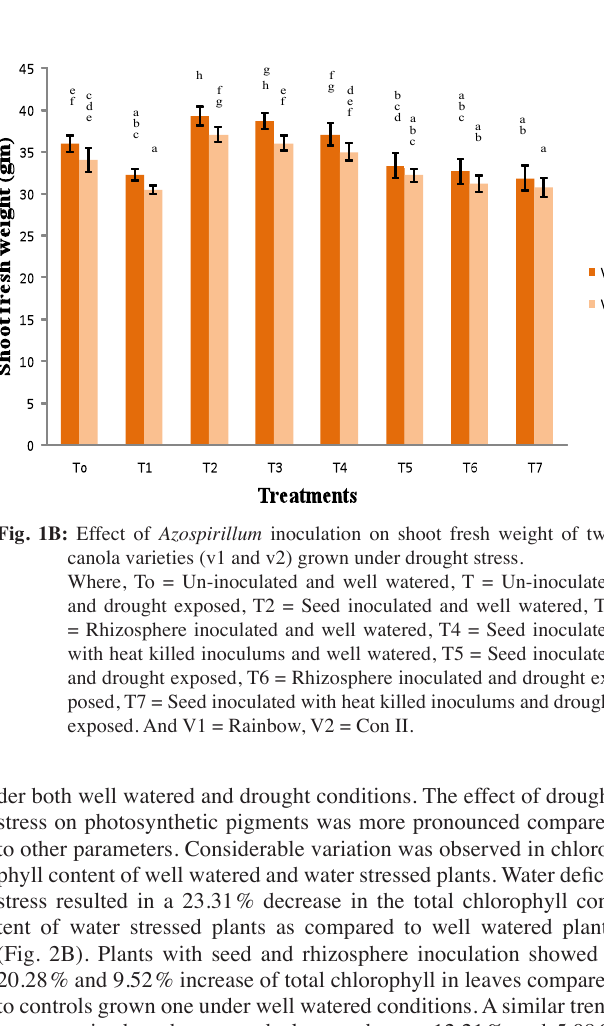
Where, To= Un-inoculated and well watered, T1= Un-inoculated and drought exposed, T2= Seed inoculated and well watered, T3= Seed inoculated with heat killed inoculums and well watered, T4= Seed inoculated and drought exposed, T5= Seed inoculated with heat killed inoculums and drought exposed. And V1=Rainbow, V2=Con II.